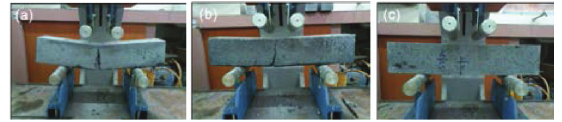
Fig. 7. Flexural failure of S1/25 (a); S1/50 (b); and S1/75 (c)